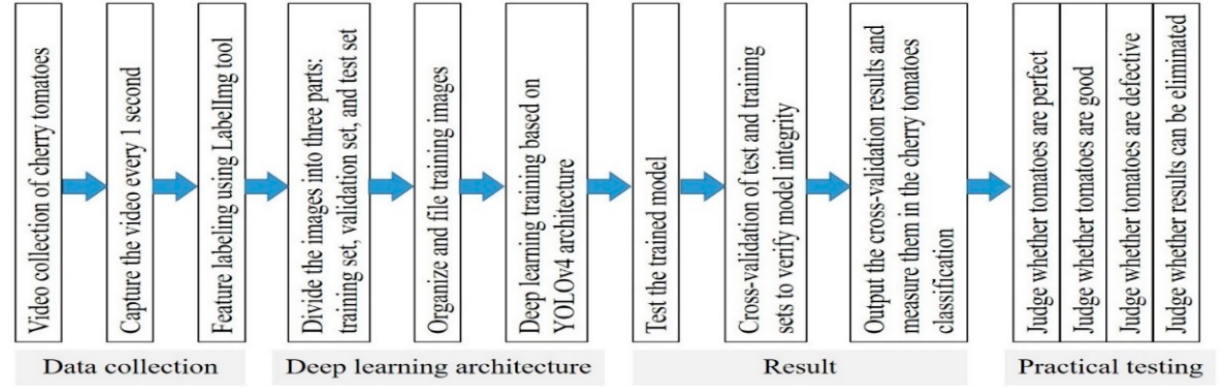
Figure 1. Flowchart of cherry tomato grading.